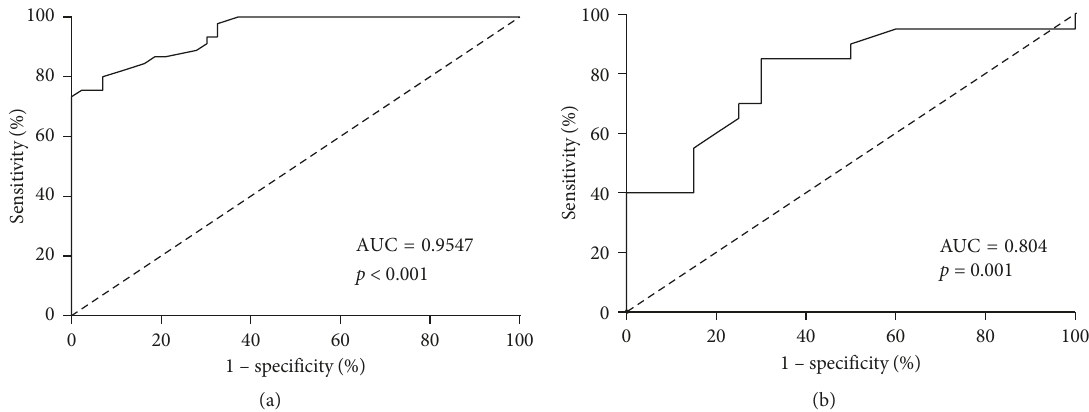
Figure 3: ROC curve for serum ADMA levels; ROC curve analysis evaluated optimal cutoff values of serum ADMA levels for predicting new occurrences of PAH (3(a) cutoff value � 0.810 μ mol/L) and moderate to severe PAH ((b) cutoff value � 0.995 μ mol/L) in CTD patients. ROC curve: receiver operating characteristic curve; AUC: area under the